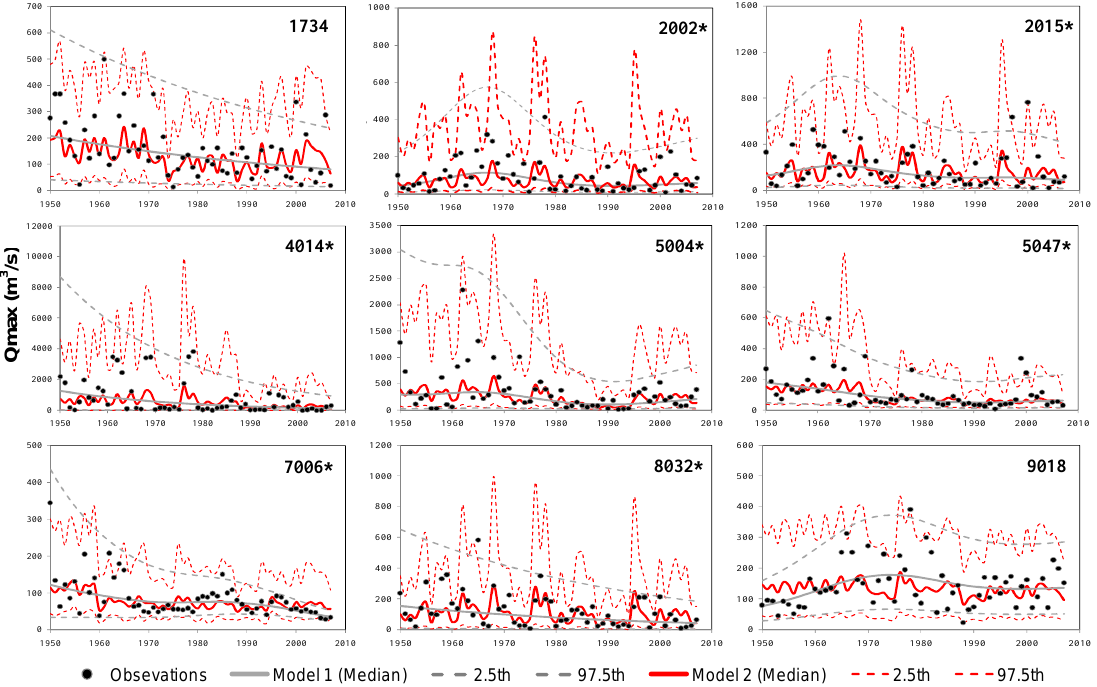
Figure 5. Summary of the results of modelling annual maximum peak discharge in nine representative sites (* means altered regime) with models 1 and 2 under non-stationary conditions. The results show the estimates of the median and the 2.5th and 97.5th percentiles.